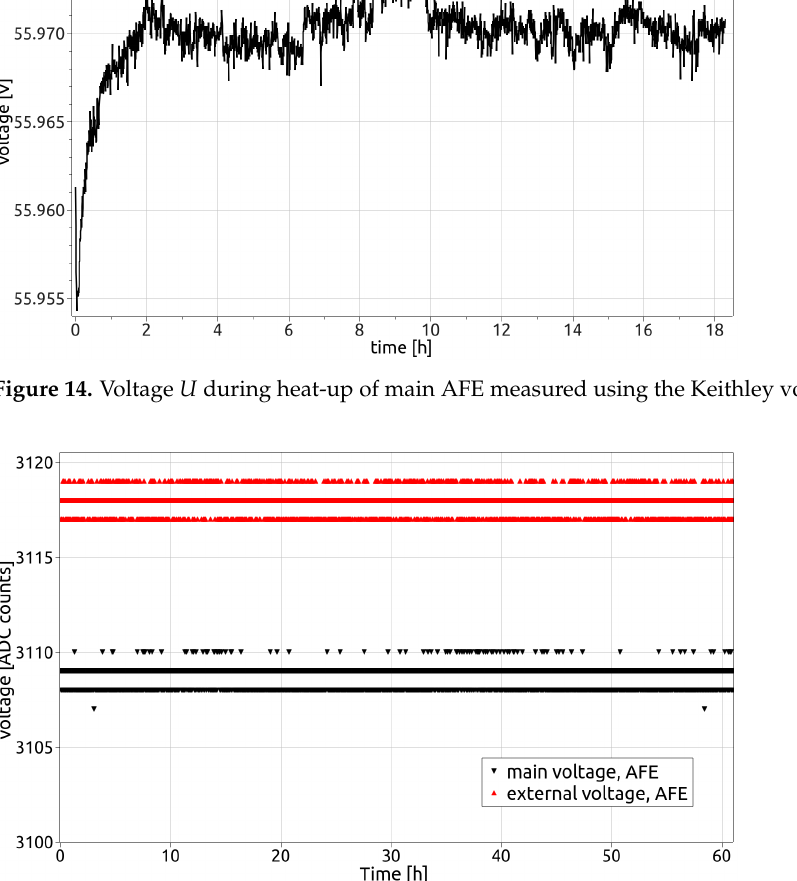
Figure 15. Long-term voltage stability measured using AFE internal voltmeter. Voltage is given in ADC